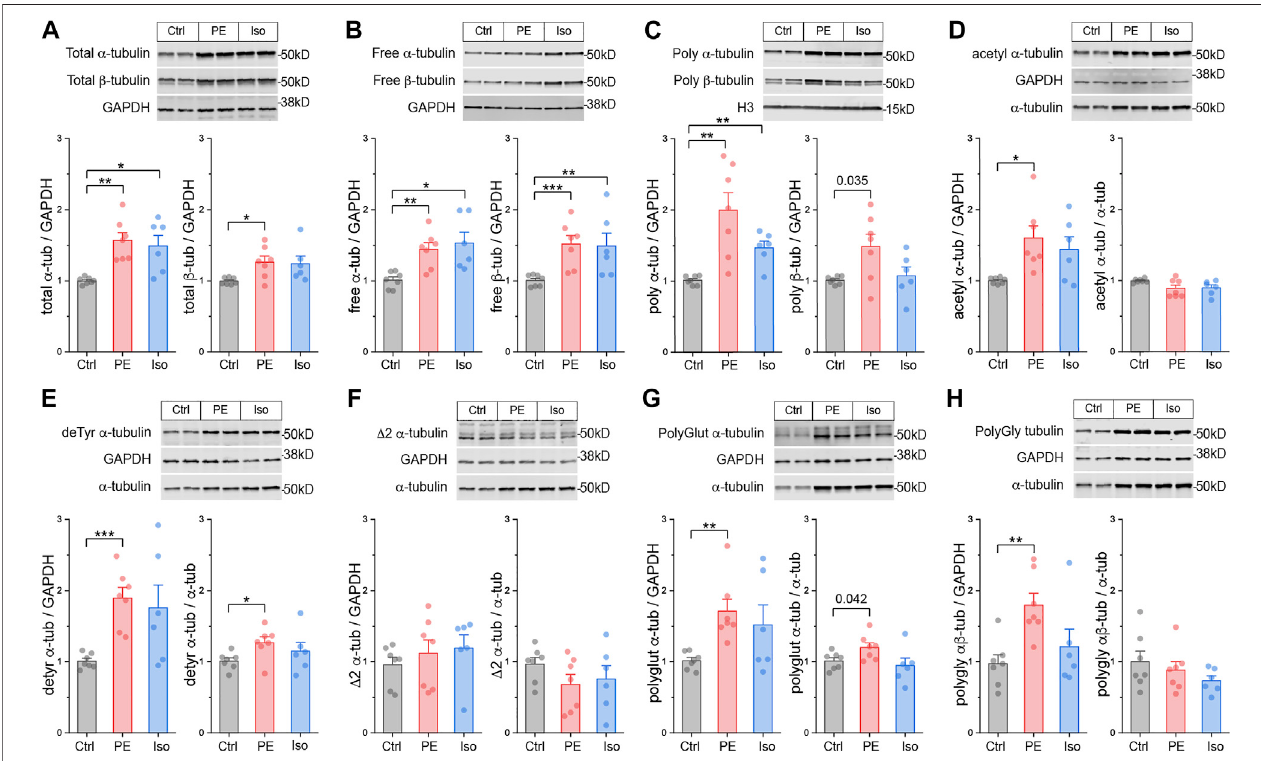
FIGURE 4 | Total tubulin content increases and the microtubule network densi fi es during hypertrophy. Representative immunoblots and relative fold-change of α - tubulin (left) and β -tubulin (right) in the (A) total proteins, (B) free, or (C) polymerized -tubulin fractions ( n = Ctrl:7, PE:7, Iso:6). Representative immuno- blots with technical duplicate lanes and relative fold-change using GAPDH (left) or α -tubulin (right) as loading controls for (D) acetylated α -tubulin, (E) detyrosinated α -tubulin, (F) Δ 2 α -tubulin, (G) polyglutamylated α -tubulin, & (H) polyglycylated pan-tubulin ( n = Ctrl:7, PE:7, Iso:6). For all bar plots, whiskers represent + 1SEM and bar represents mean; * represents p-value from Welch-corrected two-tailed two-sample t-test < 0.025 (Bonferroni-corrected for two comparisons), ** represents p < 0.01, and *** represents p < 0.001.